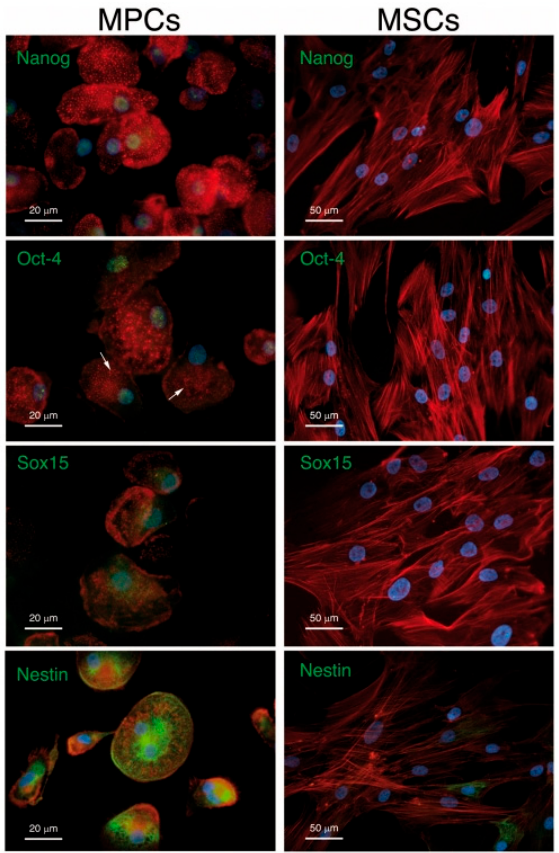
Figure 7. MPCs versus MSCs. Immunofluorescent staining confirms the expression of Nanog, Oct-4 and Sox15 (green) in MPC but not in MSC nuclei (blue) MPCs and MSCs show different spatial organization of F-actin (red). MPCs also differ from MSCs due to their unexpected high expression of well-organized Nestin filaments (green). Reused from [89] under Creative Commons Attribution License.